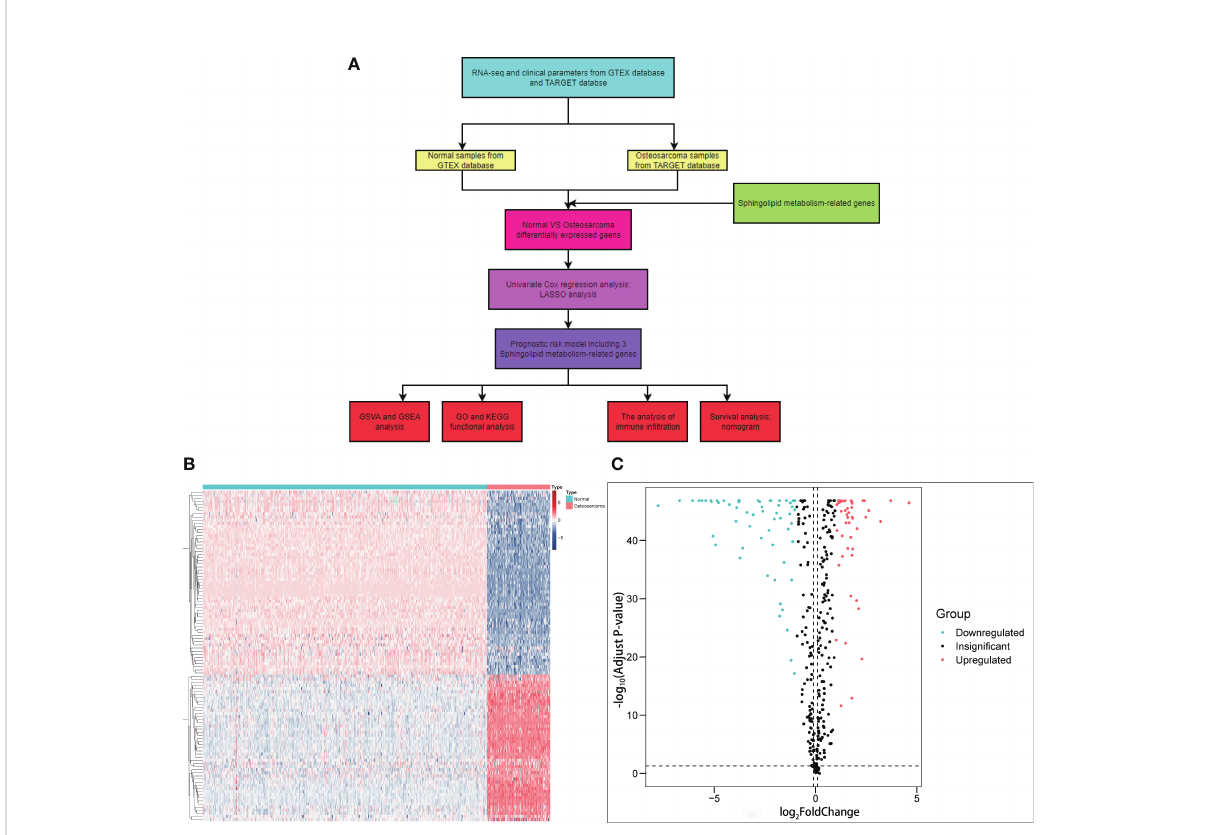
FIGURE 1 Graphical abstract and the comparison between osteosarcoma with non-tumorous tissue samples. (A) Flow chart of this study. (B) A heatmap conducted using the 106 differently expressed genes relevant with sphingolipid metabolism. (C) A volcano plot conducted using the 106 differently expressed genes relevant with sphingolipid metabolism. A total of 59 genes were downregulated, and 47 were upregulated in OS